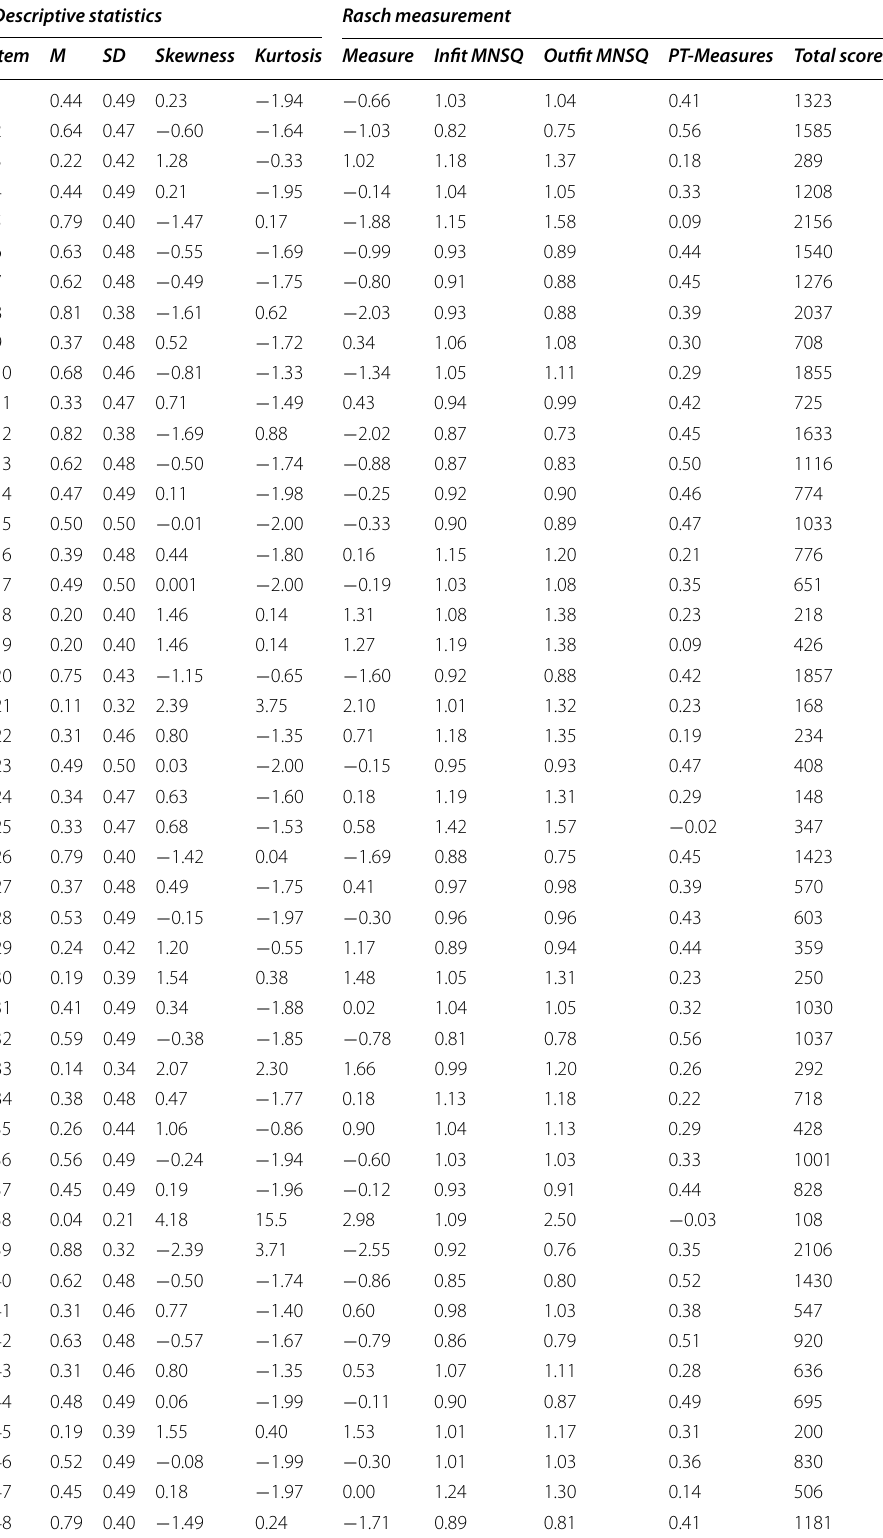
Table 20 Results of descriptive statistics analysis and Rasch measurement (IUUESEE 2019) Descriptive statistics Rasch